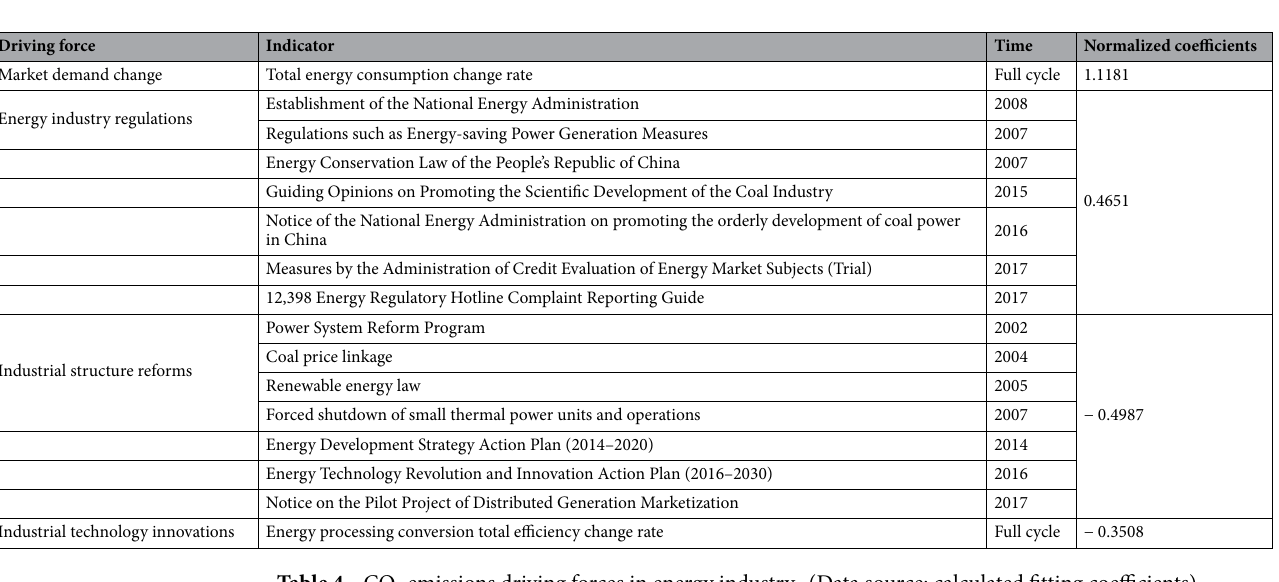
Table 4. CO 2 emissions driving forces in energy industry. (Data source: calculated fitting